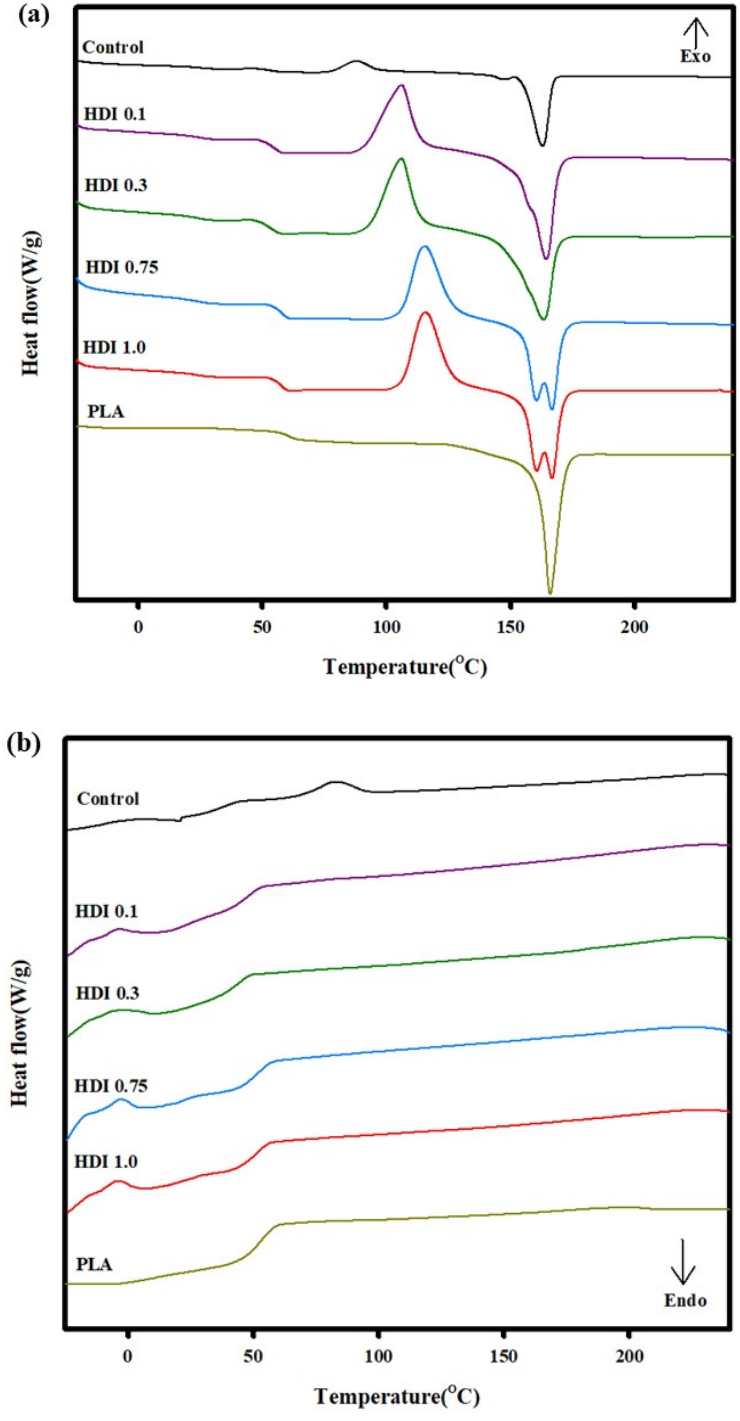
Figure 6. DSC thermal characteristics of control and blend specimens prepared with various HDI contents, ( a ) 2nd heating and ( b ) 2nd cooling.